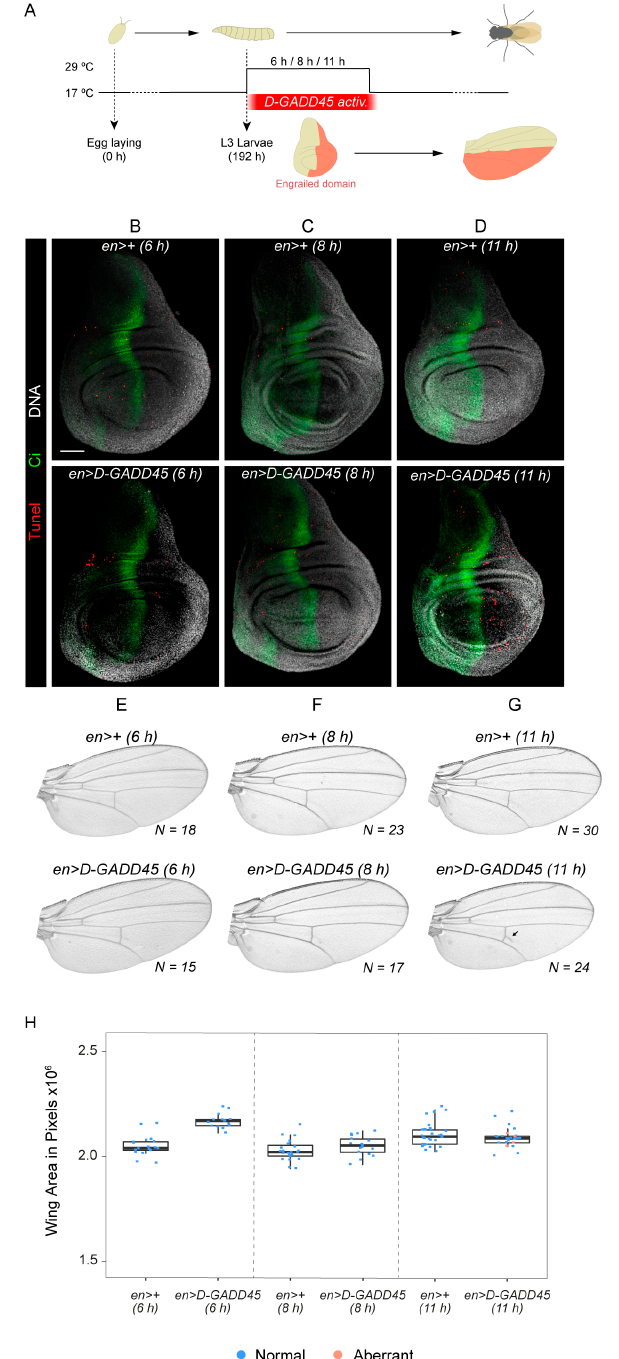
Figure 3. Transient expression of D-GADD45 is not su ffi cient to induce cell death. ( A ) Schematic representation of D-GADD45 transient activation in the posterior ( engrailed, en ) compartment. The a ff ected domain is represented in orange. ( B – D ) TUNEL assay of wing imaginal discs labeling apoptotic cells (red), the anterior compartment (Ci: Cubitus interruptus, green) and DNA (white). N = 5 for each condition. Scale bar: 50 µ m. ( E – G ) Adult wings showing the predominant phenotype observed after transient expression of each construct in the posterior ( engrailed , en ) compartment. Number of wings analyzed is indicated for each condition. ( H ) Box plots showing the average area of adult wings. Each dot represents one wing; normal (blue) and aberrant pattern